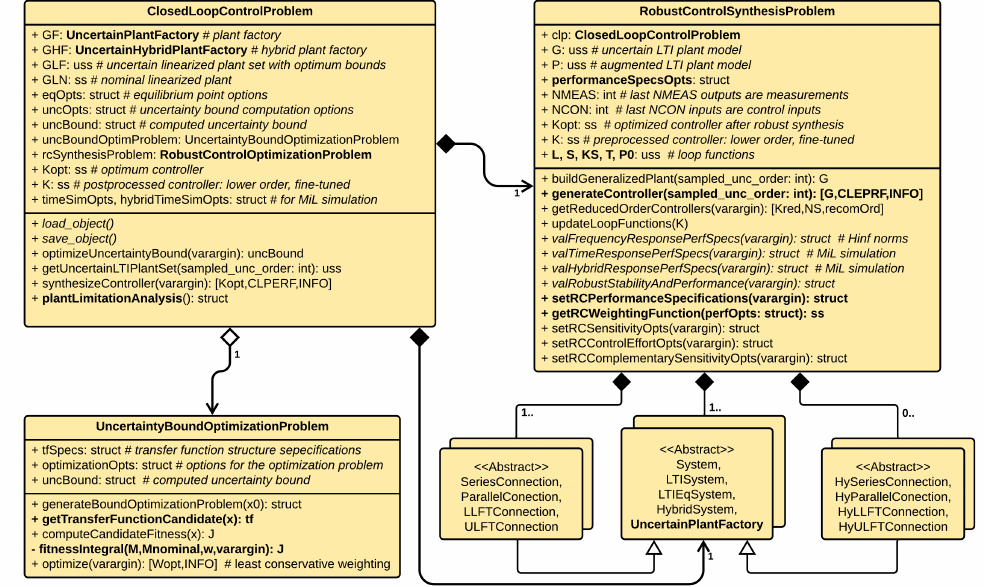
Figure 4. Closed loop control problem class which encompasses an uncertain plant set with operating point specification, options for automatically modeling the plant uncertainty, specifying robust control performances, synthesizing controller, and validating obtained